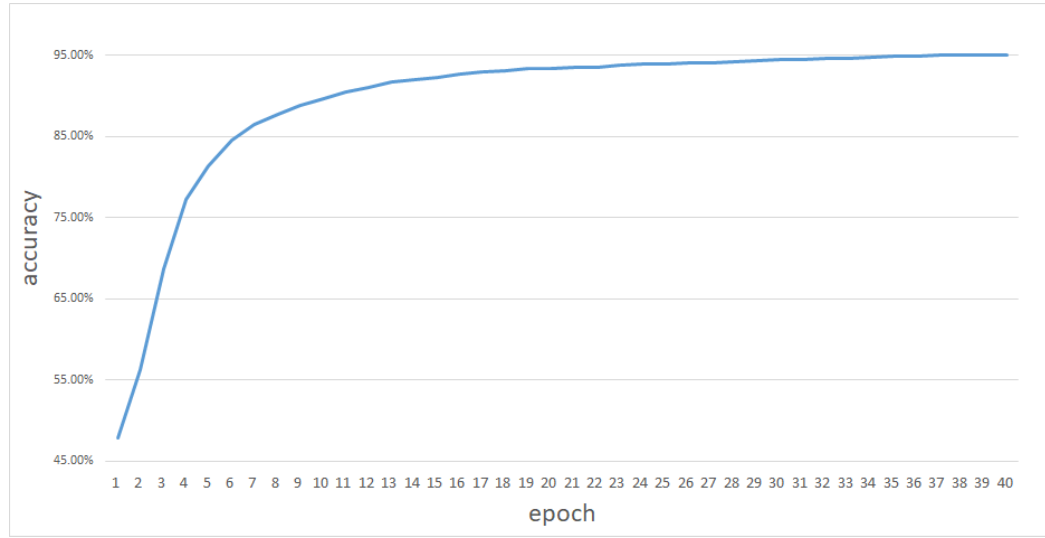
Figure 8. The accuracy changes with epochs. Table 2. Tasks and corresponding evaluation indicators.